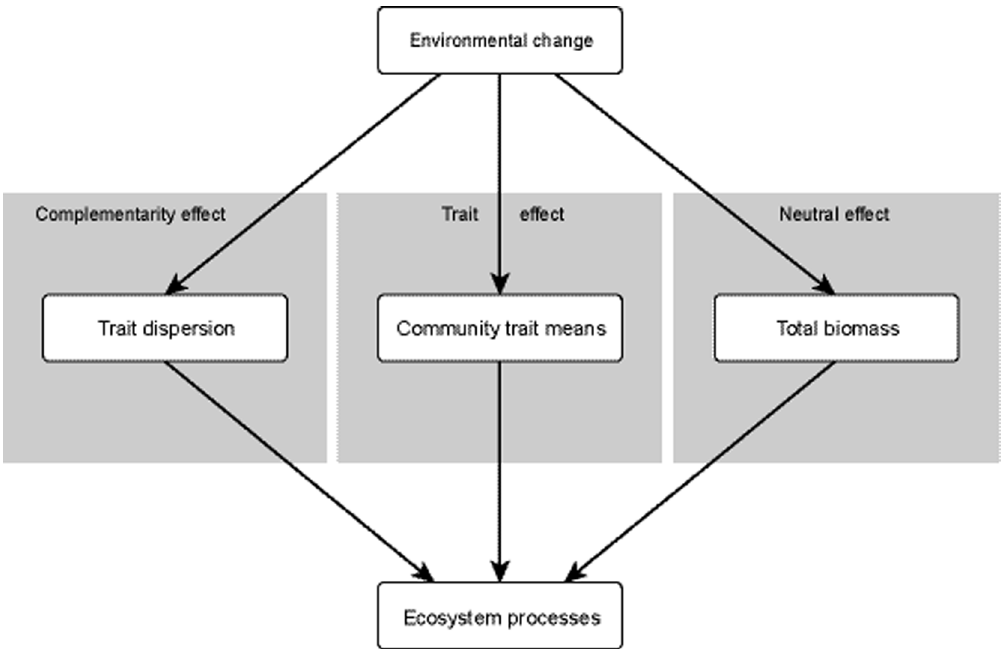
Fig. 1. Hypothetical causal pathways of the effects of environmental change on insect-mediated ecosystem processes. Shaded boxes indicate the causal hypotheses (complementarity effect, trait-mean effect, or neutral